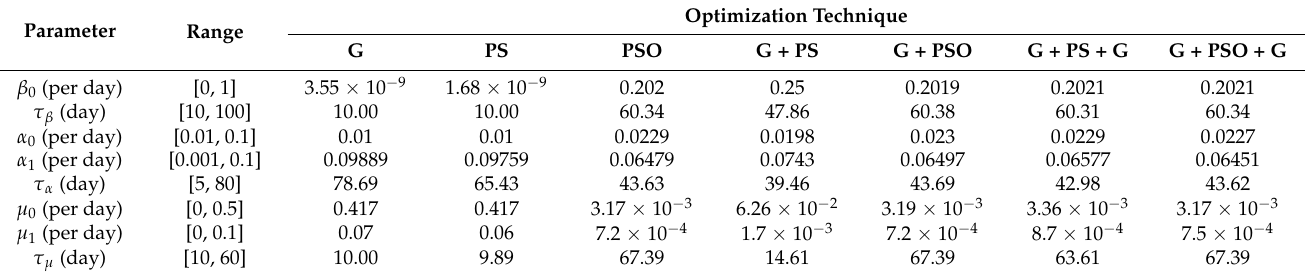
Table 1. Estimated model parameters.